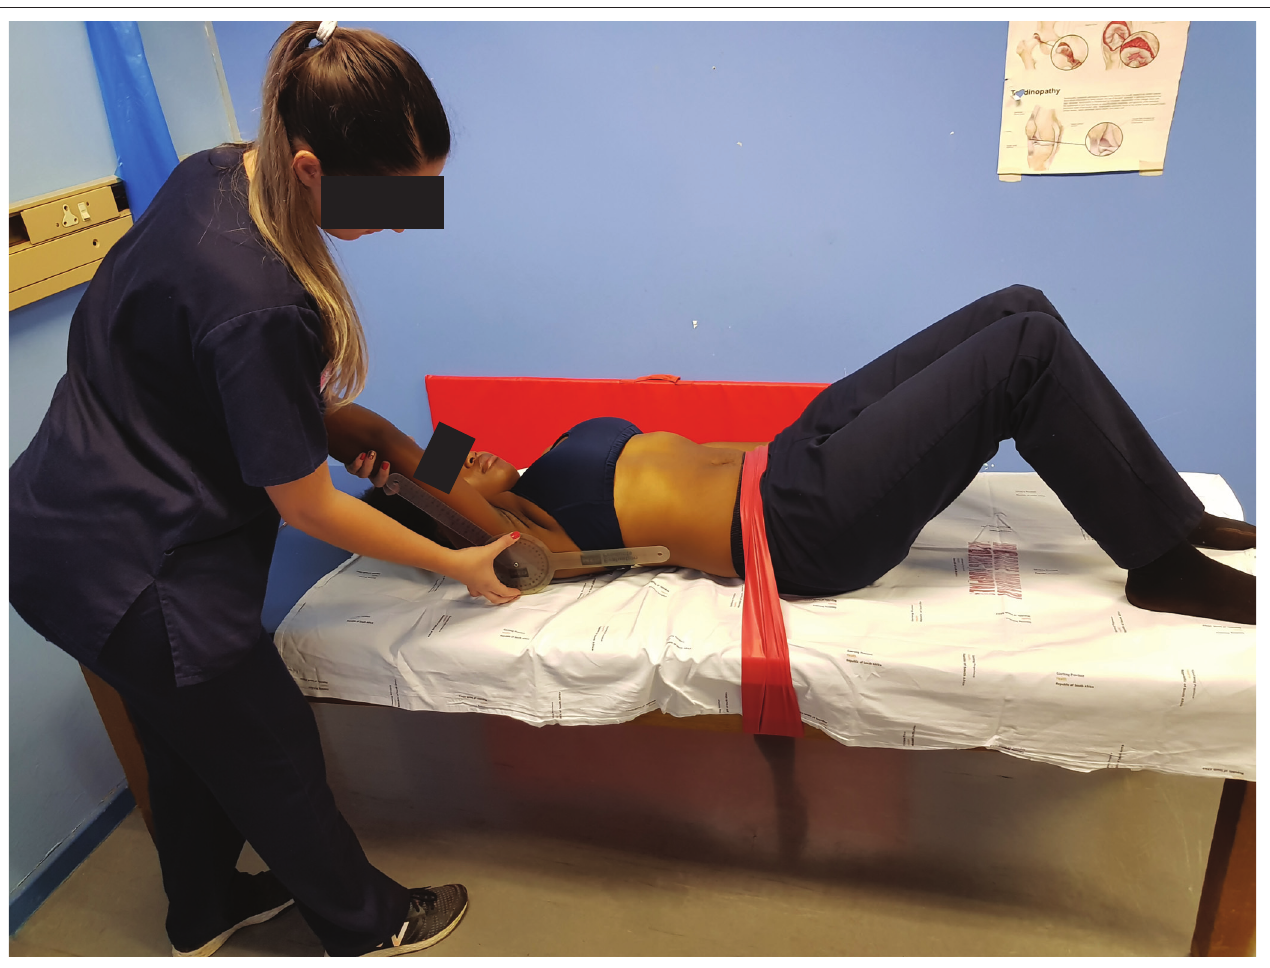
FIGURE 2: A photo of the test position illustrating scapulae and glenohumeral joint